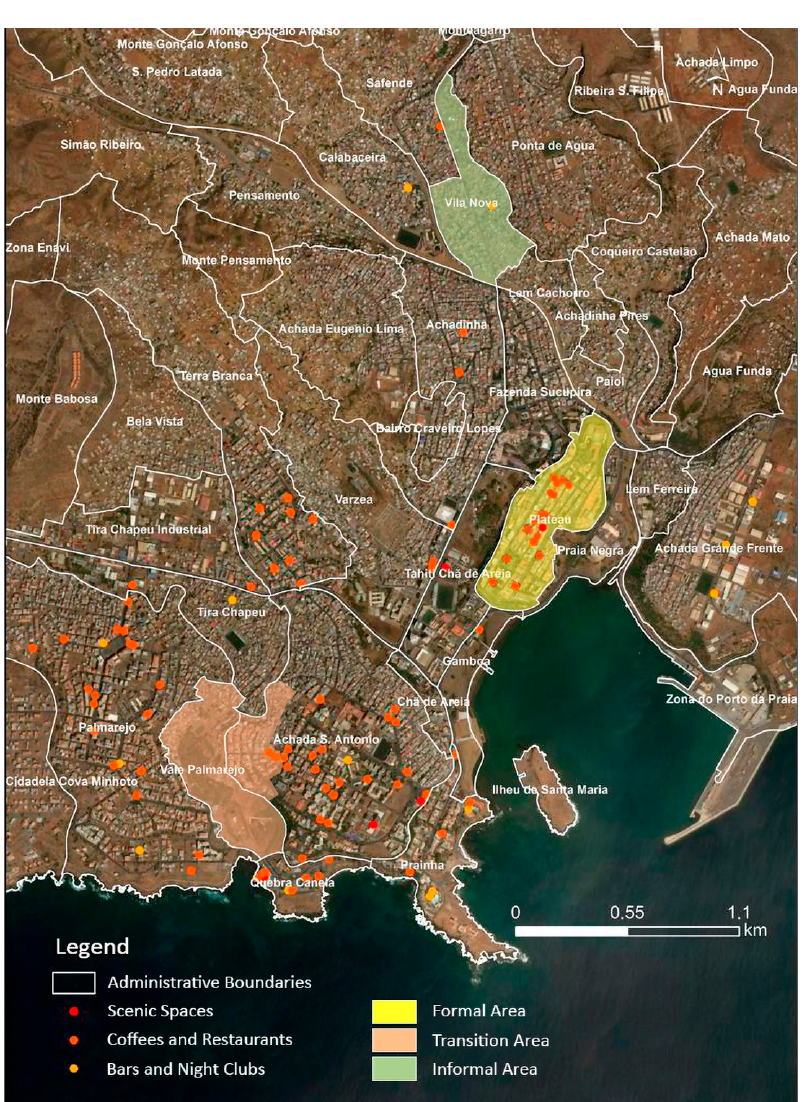
Figure 1. Recreational infrastructures in the city of Praia in 2014.